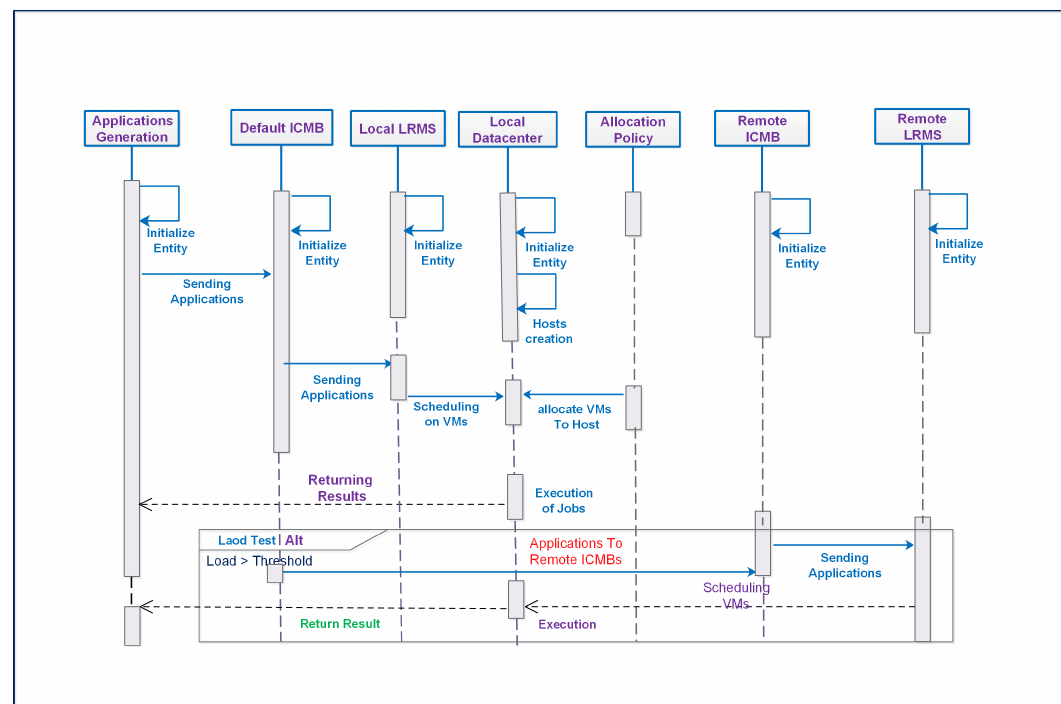
Figure 4. Application Sequence in Federated Entities.